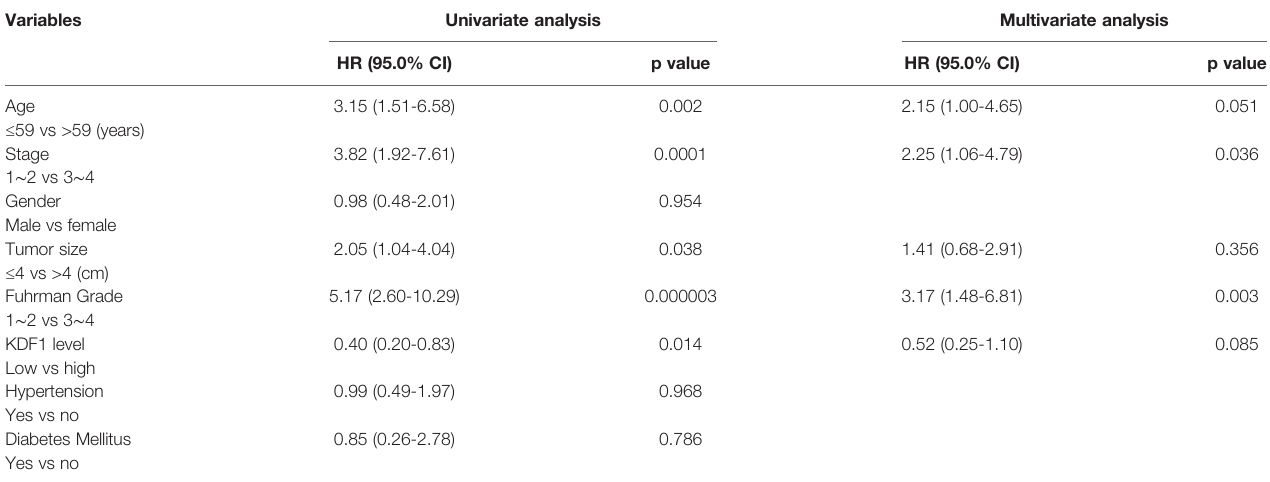
TABLE 2 | Univariable and multivariable Cox regression analysis for overall survival.